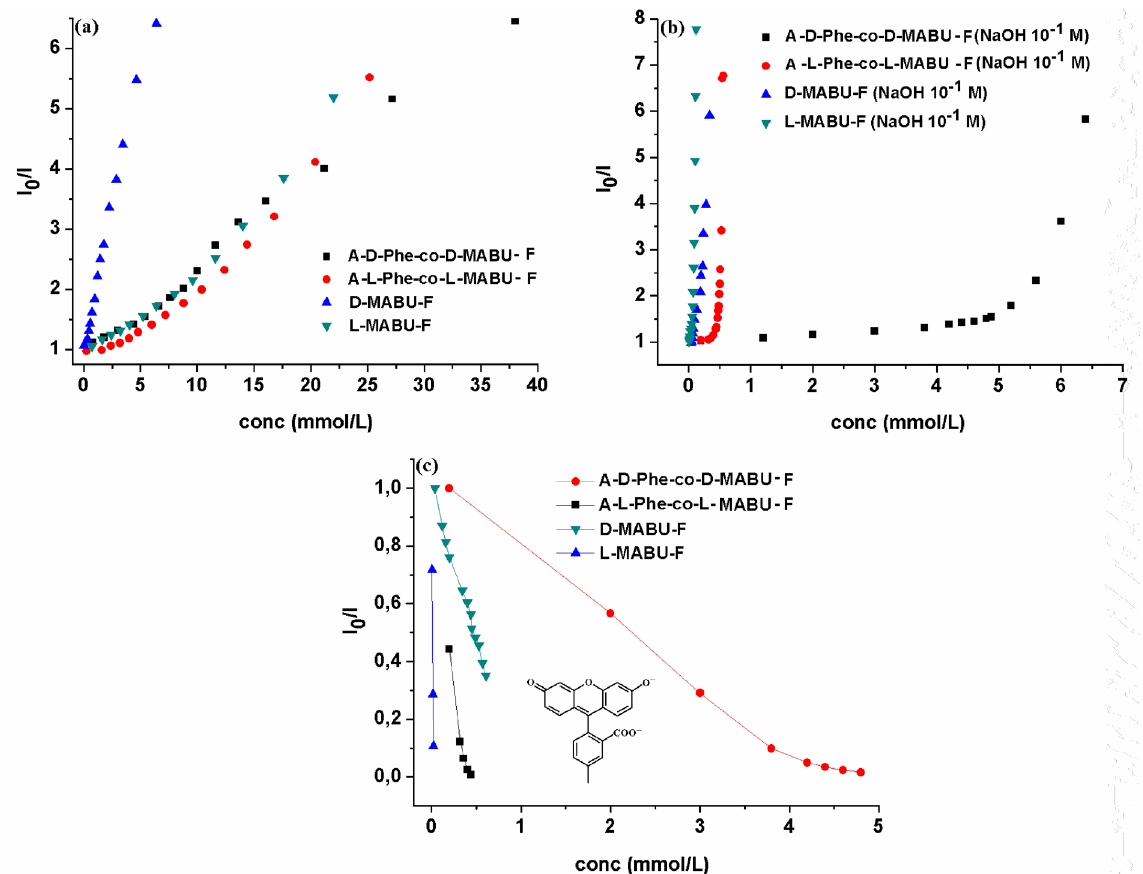
Figure 8. Stern–Volmer plots for copolymers A-D-Phe-co-D-MABU-F and A-L-Phe-co-L-MABU-F, and their model compounds in presence of HCl 10 -1 M (a) and NaOH 10 -1 M (b) - the first maxim from 406 and 409 nm for monomers (D-, L-), and at 409 for (D-, L-) copolymers, and (c) - the second maxim from 537 nm for monomers (D-, L-,) and at 532 and 535 nm for (D-, L-)